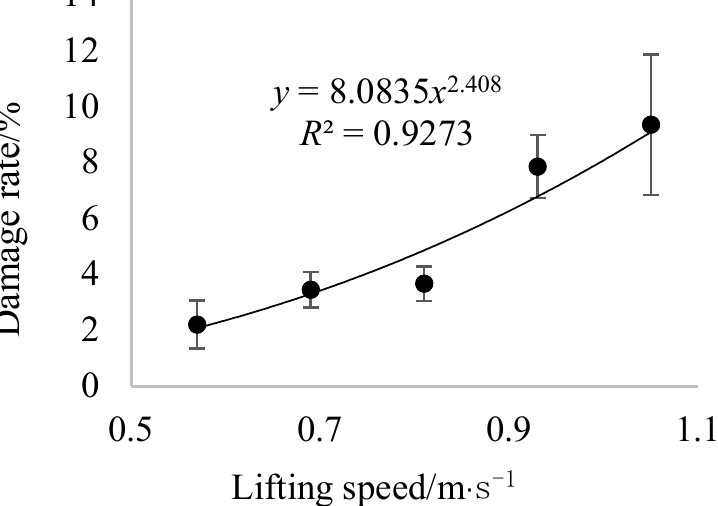
Figure 10. Effect of equivalent friction on damage rate on lifting speed. Note: working speed was 1.48 km · h − 1 , digging depth was 90 mm, and cutting height was 70 mm.